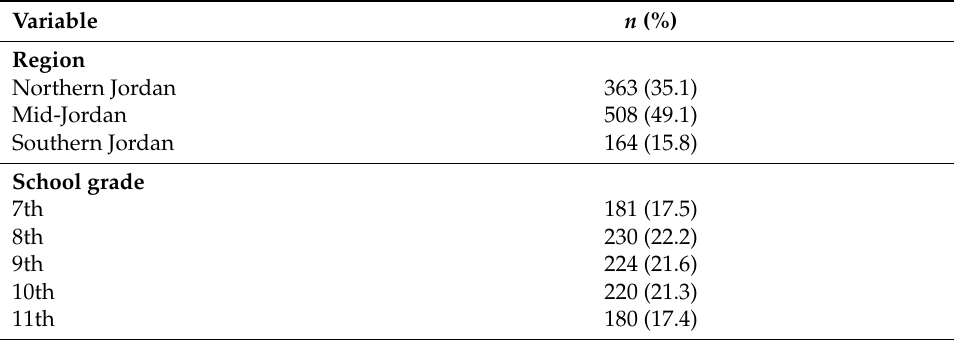
Table 1. Socio-demographic characteristic of Jordanian